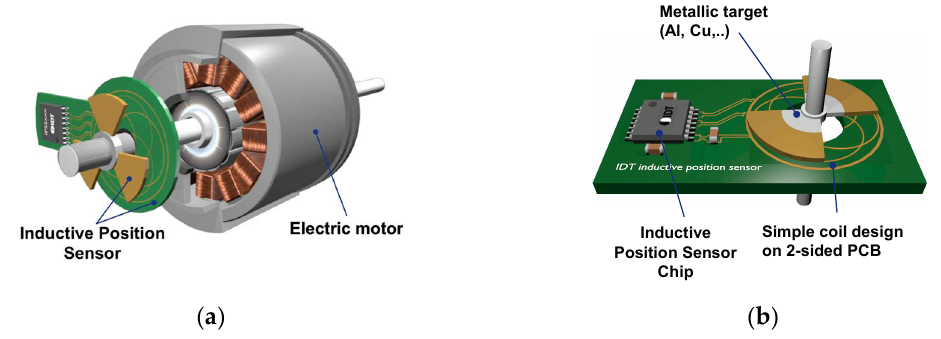
Figure 4. Inductive position sensor, reproduced from [16]. Copyright 2019, IDT. ( a ) Illustration of a through-shaft integration; ( b ) Relevant sensor components scheme.